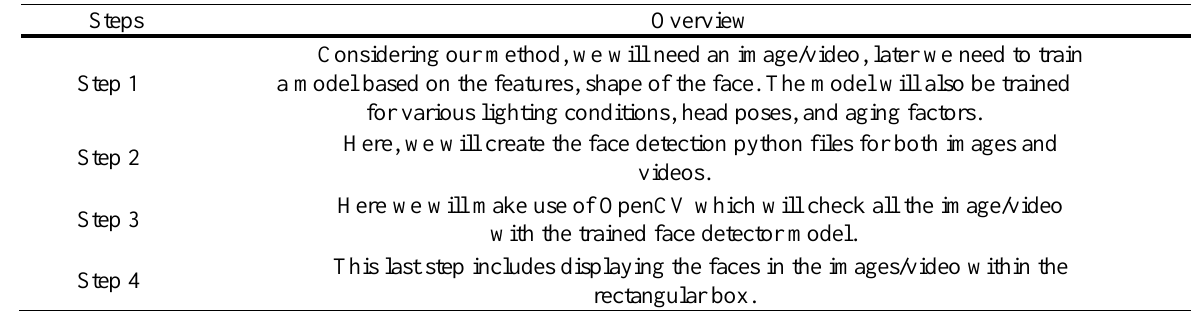
Table 4. Proposed deep neural